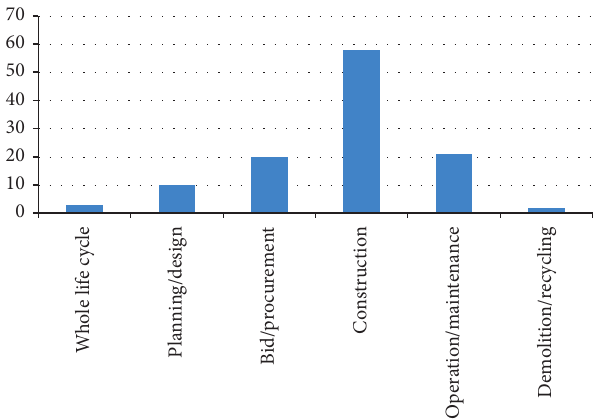
Figure 1: Distribution of reviewed articles by project